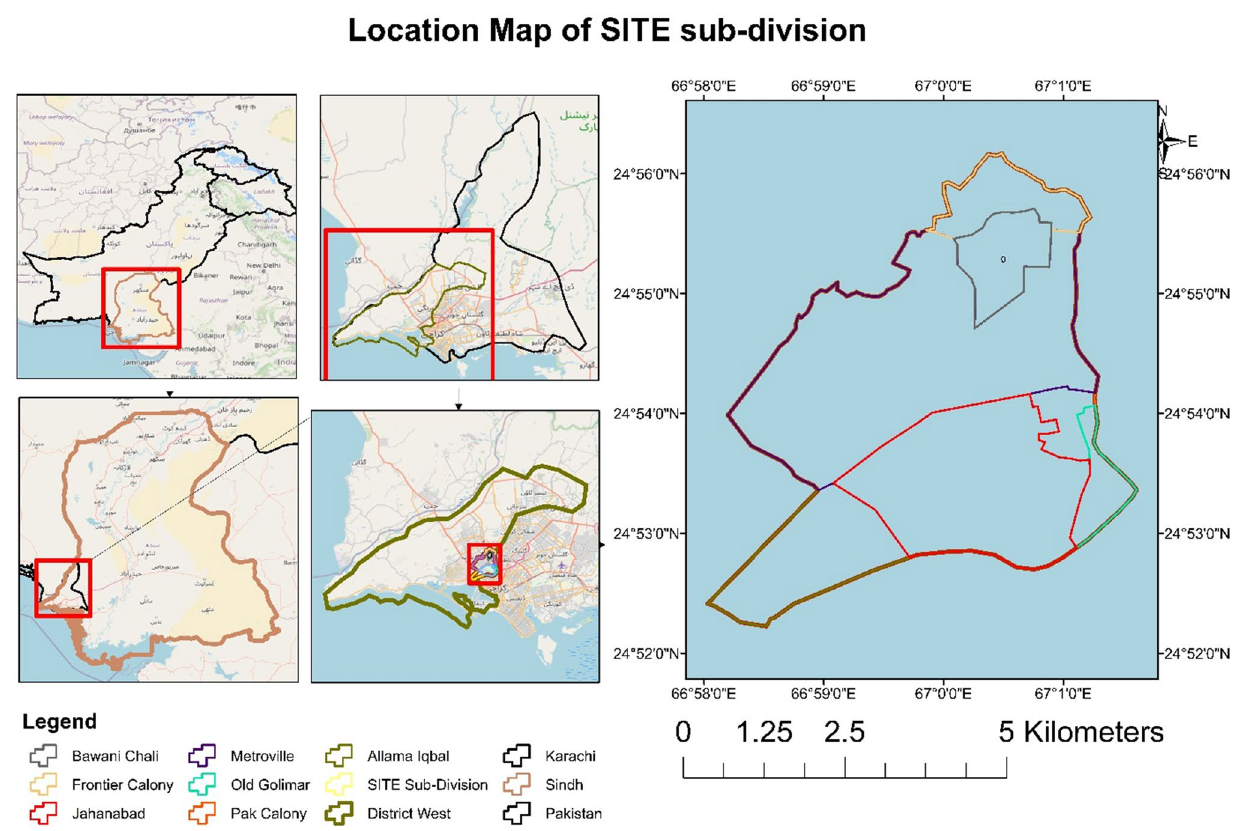
Fig. 2 Location of SITE sub-division study area (GOP 2017, Geological Survey of Pakistan